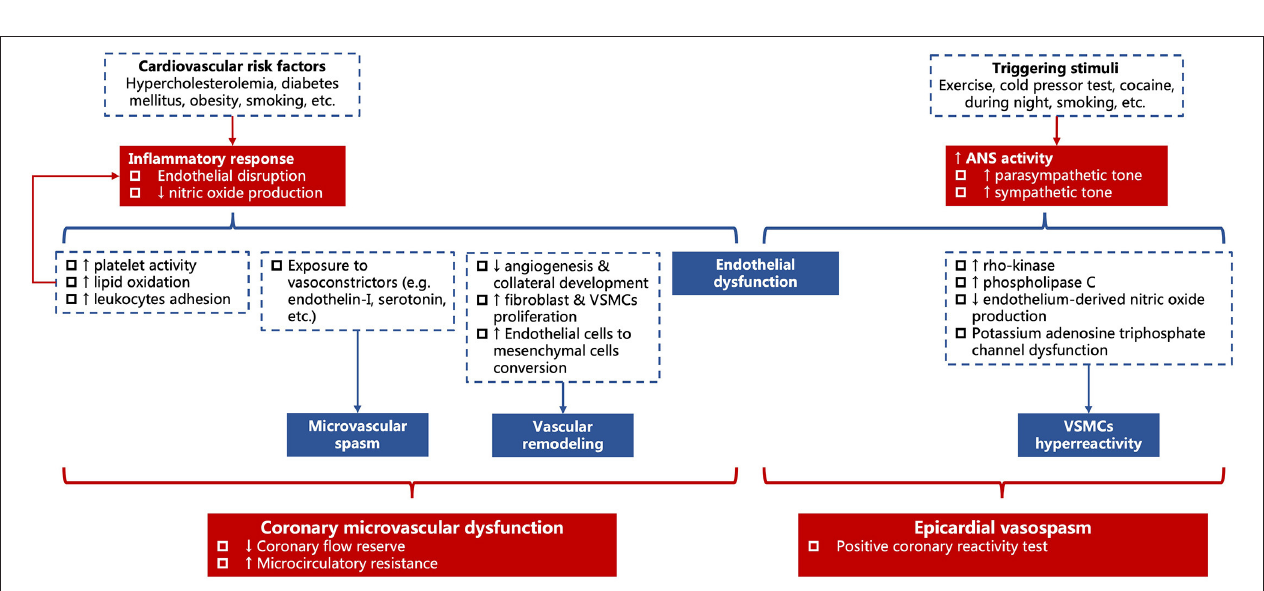
FIGURE 2 | Diagram for the association between risk factors and hemodynamic changes in coronary microvascular dysfunction and epicardial vasospasm. VSMCs, vascular smooth muscle cells.